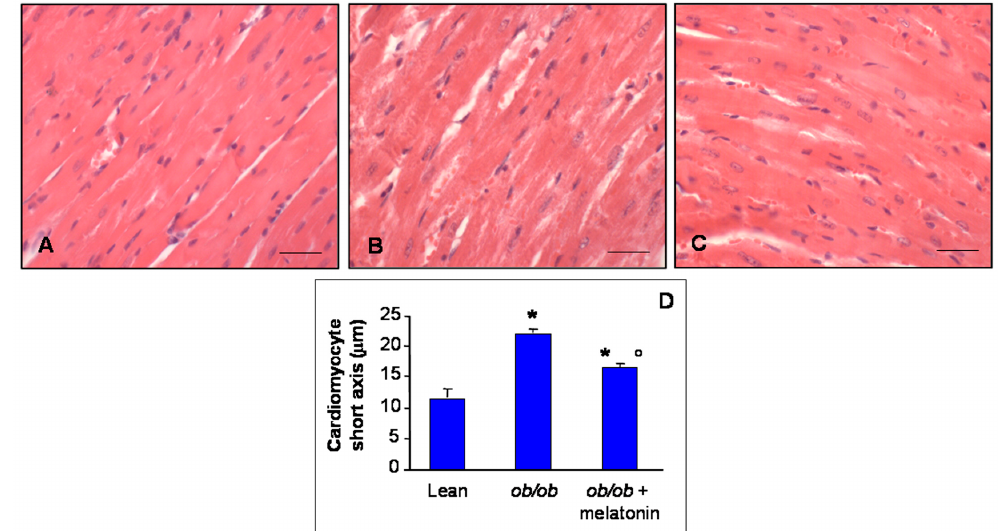
Figure 1. Histomorphometrical evaluation. Photomicrographs showing ventricular cardiomyocytes of lean mice treated and not treated with melatonin ( A ), ob / ob mice ( B ) and ob / ob mice treated with melatonin ( C ). Lean mice treated or not with melatonin displayed similar “normal” morphological data, so they are defined generically as “lean” mice. Note in ob / ob mice supplemented with melatonin there is a partial restoration of proper cytoarchitecture in longitudinal heart sections. Haematoxylin-eosin staining. Scale Bar = 20 µm. The graph ( D ) summarized the analyses of ventricular cardiomyocytes short axis. * p ≤ 0.05 significant vs. lean mice; ° p ≤ 0.05 significant vs. ob / ob mice.